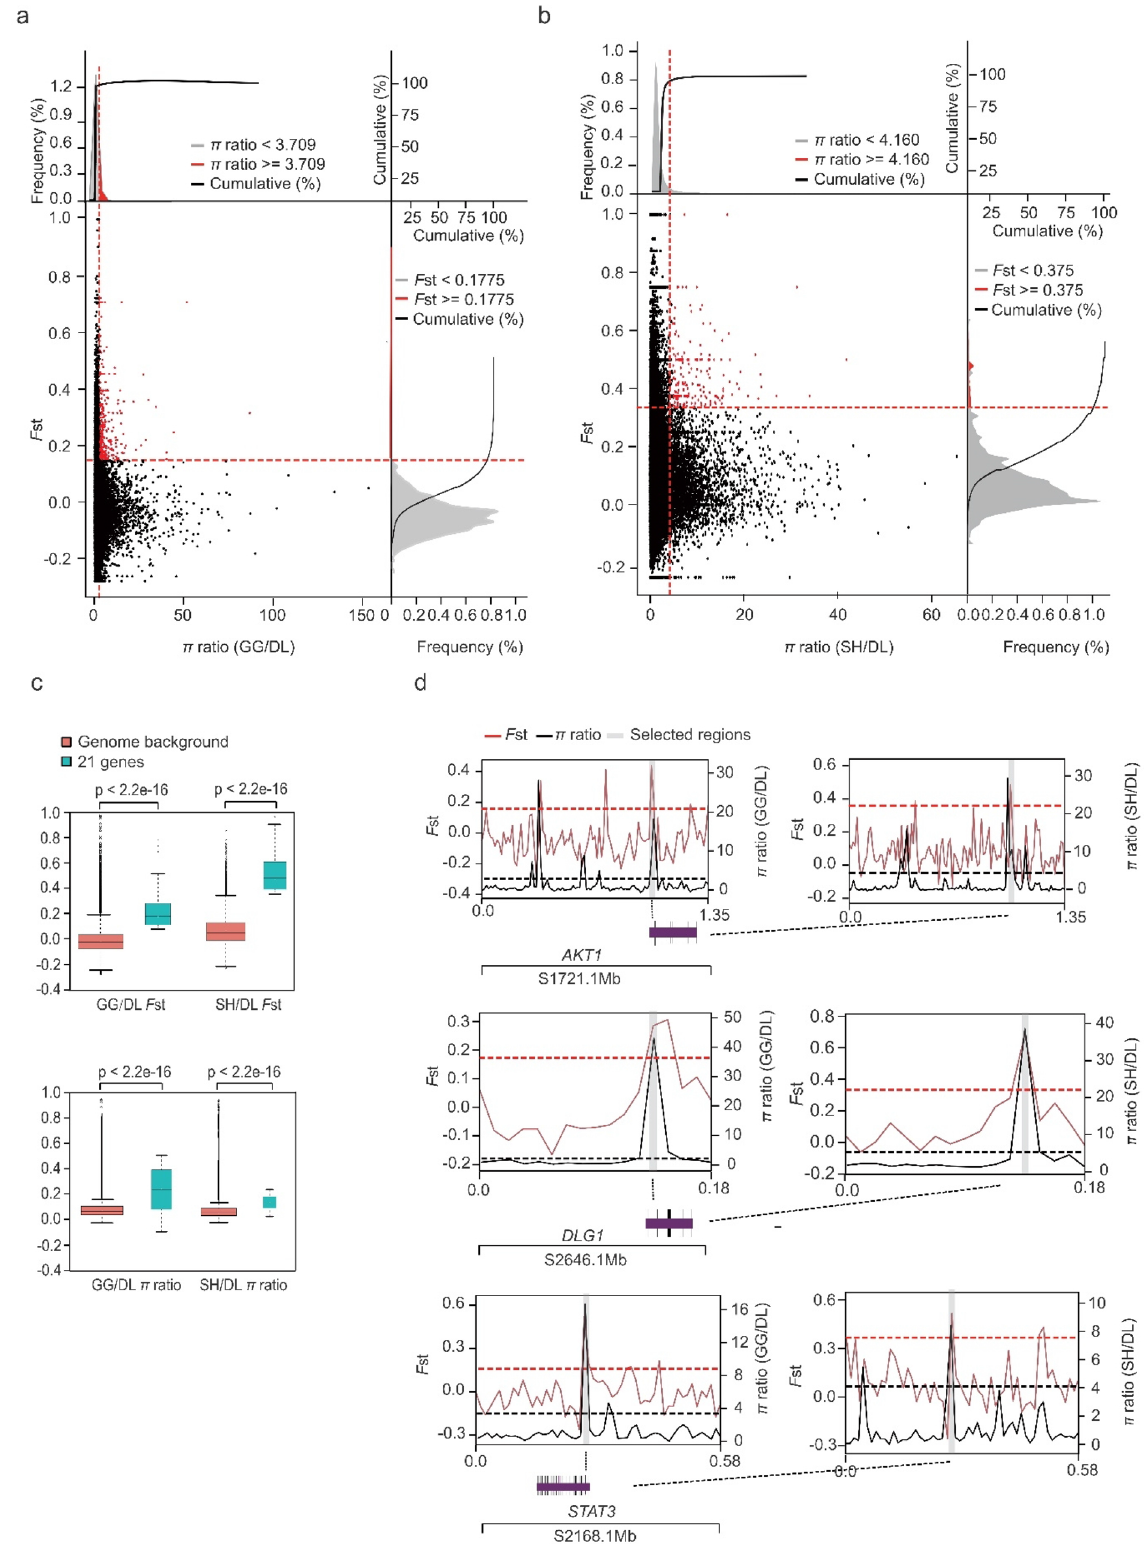
Figure 4. Genomic regions under selective sweeps. ( a , b ) Distribution of the F st and π ratio values, calculated in 10-kb windows with 10-kb sliding steps. Red data points were identified as selective sweeps that passed the thresholds of π ratio (the top 5% of the empirical distribution of π ratio, π ratio >= 3.709 in GG/DL and π ratio >= 4.160 in SH/ DL) and F st (the top 5% of the empirical distribution of F st, F st >= 0.1775 in GG/DL and F st >= 0.375 in SH/DL). ( a ) The F st and π ratio of GG/DL. ( b ) The F st and π ratio of SH/DL. ( c ) Box plot of π ratio and F st values for twenty-one genes versus the whole genome. ( d ) Representative common genes of two pairwise groups with strong selective sweep signals. Genome annotations are shown at the bottom, and black bars represent coding